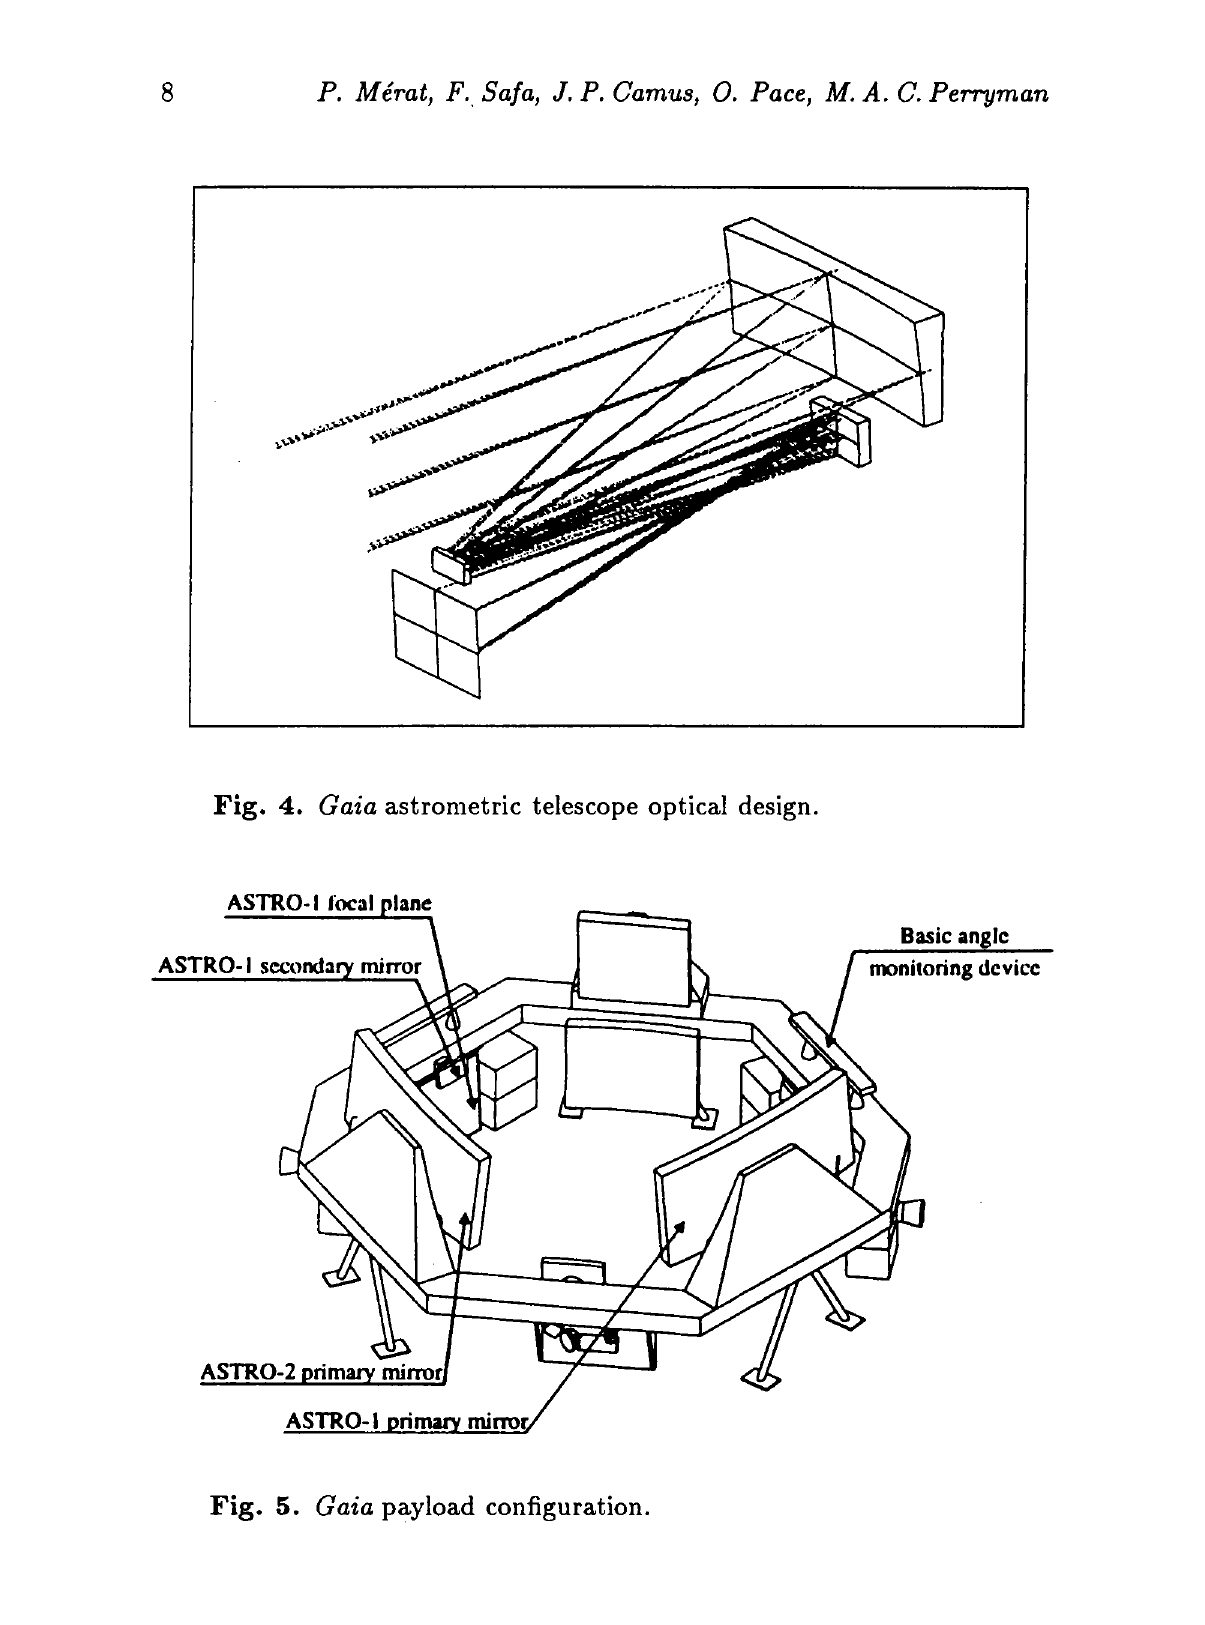
Fig. 5. Gaia payload